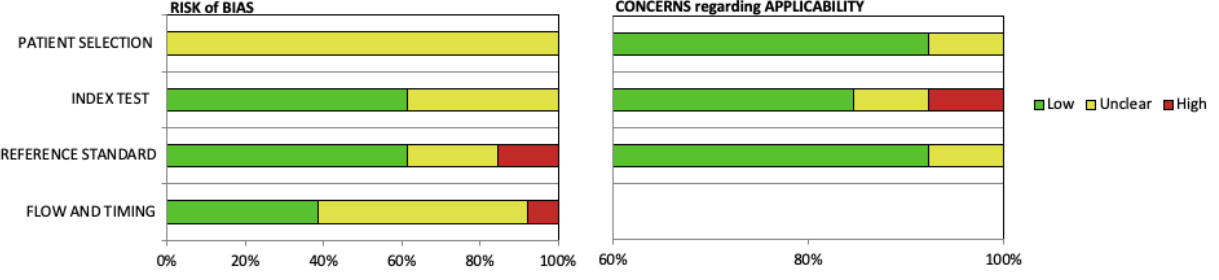
Figure 5. Flow-chart depicting methods of included articles, generally applicable to all included studies. AUC area under curve, RMSE root–mean square error. 4. Discussion The surgical community currently lacks a gold standard for objective iAE identifica- tion and reporting in the literature, and without standardization, our ability to accurately define surgical complications remains limited. AI represents a potential solution for iden- tifying and capturing iAEs, but has been used sparingly, as demonstrated in this review. The majority of the literature in this review was published after 2020, highlighting the